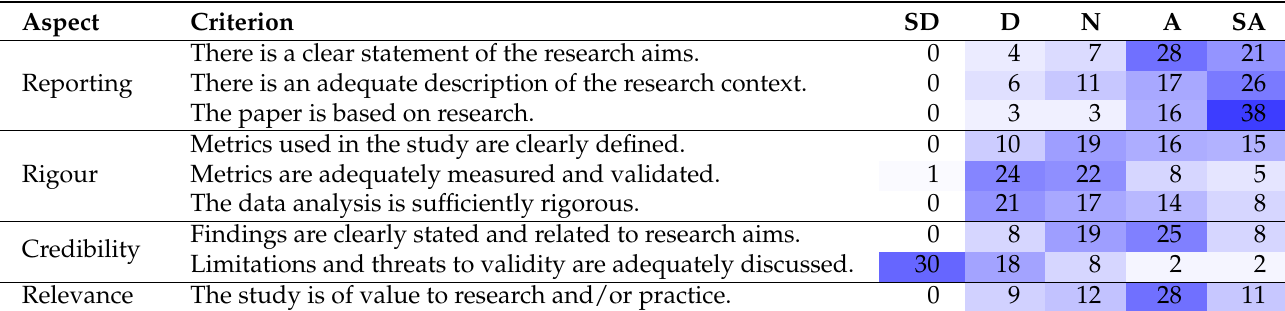
Table 4. The quality criteria applied to 60 papers during the quality assessment phase. Possible responses were strongly disagree (SD), disagree (D), neutral (N), agree (A), or strongly agree